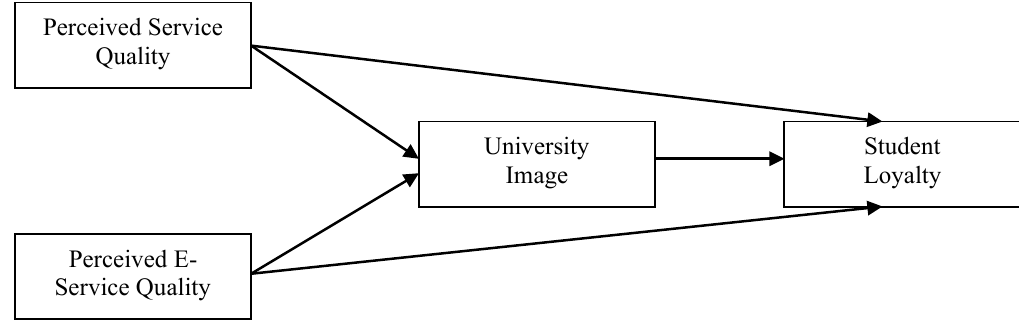
Figure 1 . Theoretical framework. Adapted from “Mediating Effect of Corporate Image and Students’ Satisfaction on the Relationship between Service Quality and Students Loyalty in TVET HLIs,” by